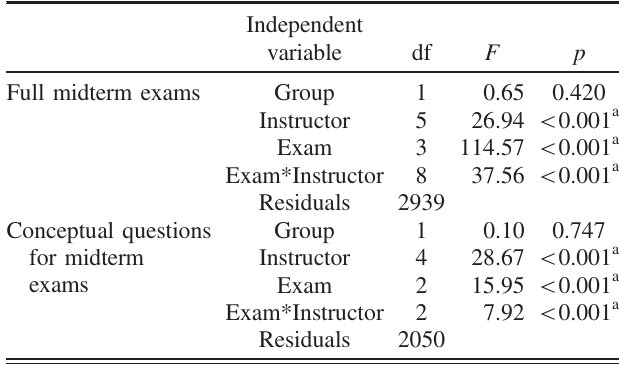
TABLE IV. The repeated-measures ANOVA analysis of stu- dents ’ difference scores across midterm exams at each institution shows no significant effect for enrolling in the